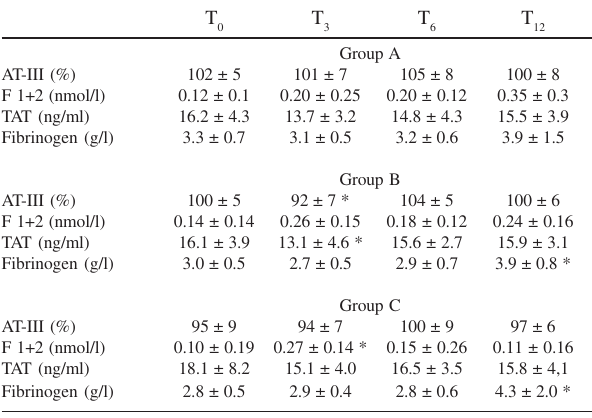
* p < 0.05, compared to initial values. The normality rates for each test: AT- III (antithrombin III) – 70 to 120%; F 1+2 (fragment 1 + 2) < 1.1 nmol “ L; TAT (thrombin-antithrombin III complex) – 10 to 41 ng/mL; fibrinogen 2 to 4 g/L.